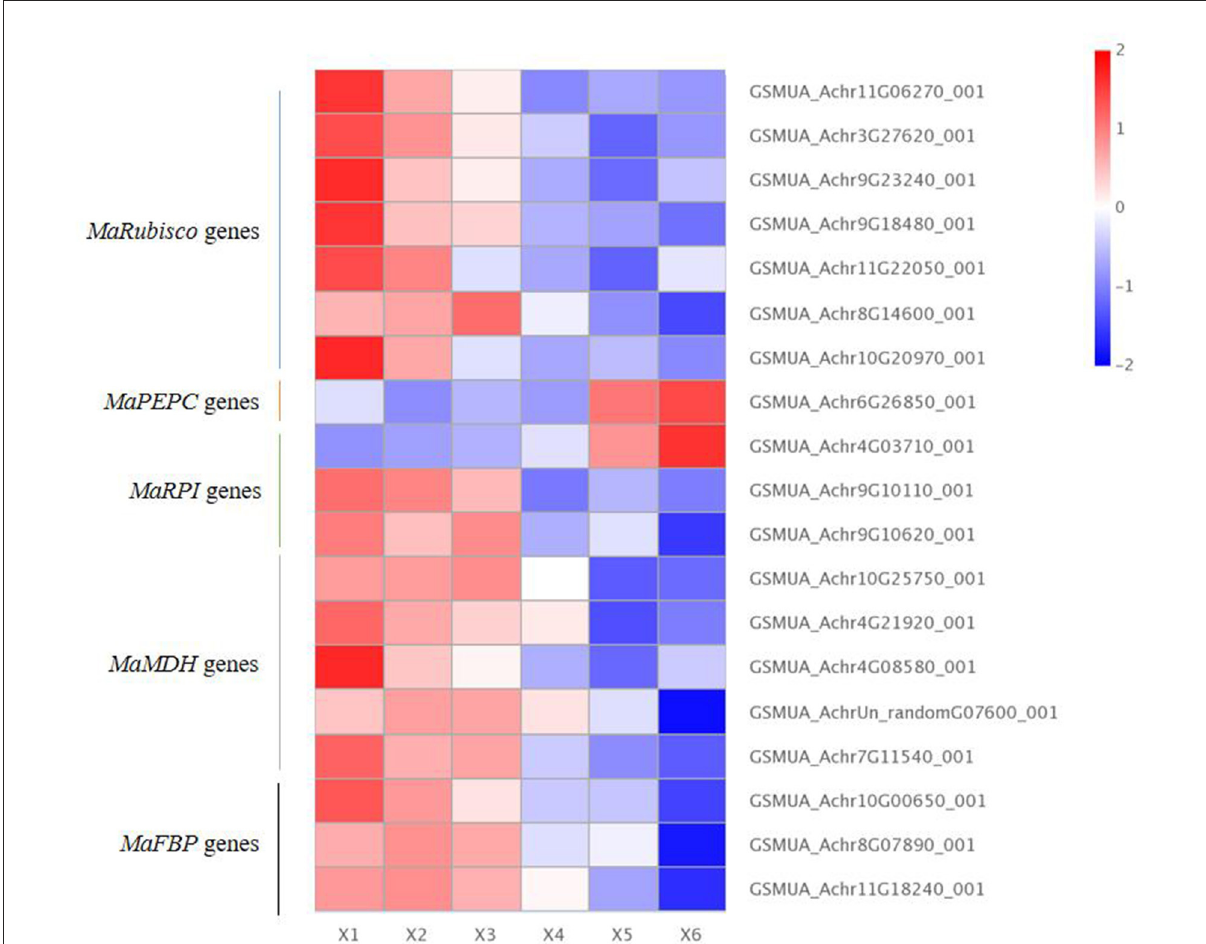
FIGURE6 Photosynthesis differentially expressed genes in diploids and autotetraploids of Pisang Berlin. X1, X2, and X3 represented the diploid banana plants, and X4, X5, and X6 represented the autotetraploid banana